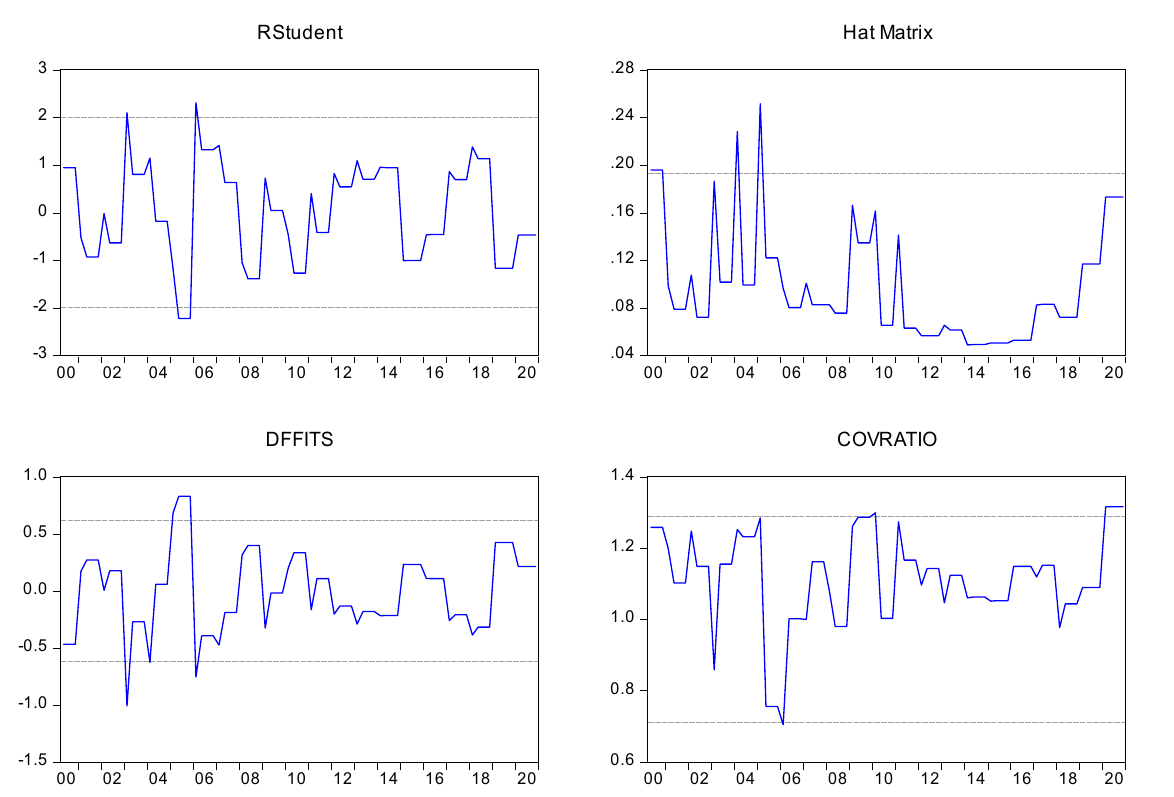
Figure 2. Influence Statistics. Note: Blue lines show observation plots between the two parallel black dotted lines. Black dotted lines show average observation plots. Source Author’s estimate.